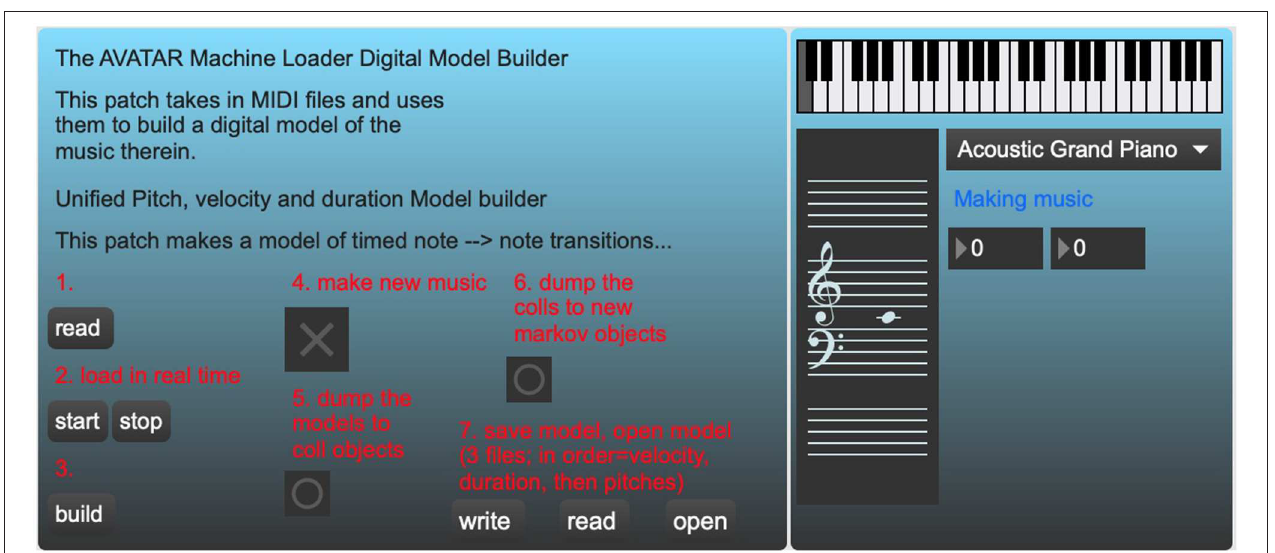
FIGURE 5 | AvatarMachineLoader.maxpat, a standalone Max program that builds a Markov model of pitch transitions from MIDI files.